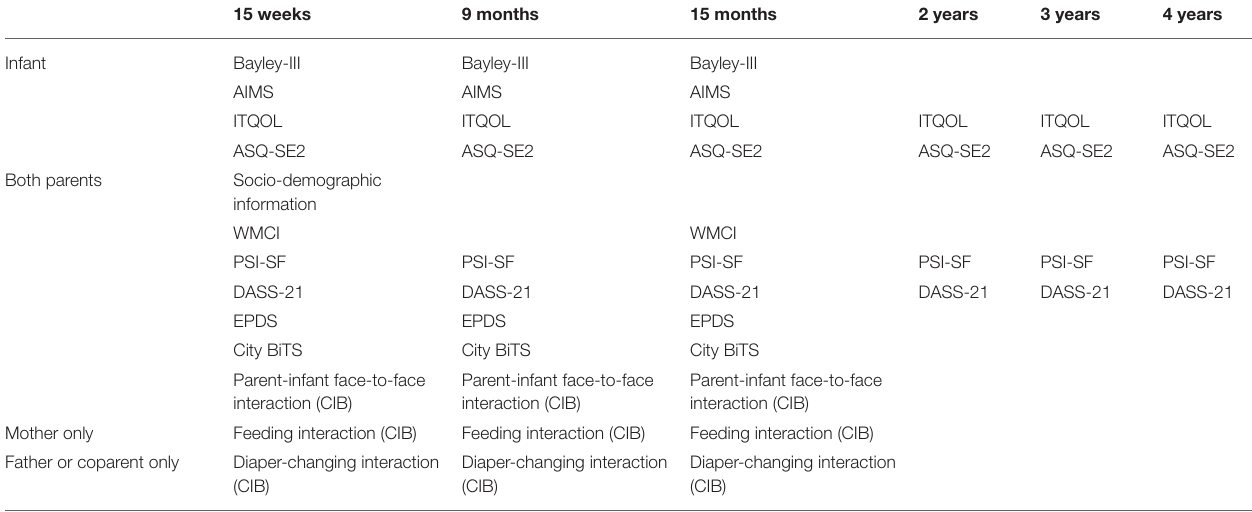
TABLE 1 | Measures used in the